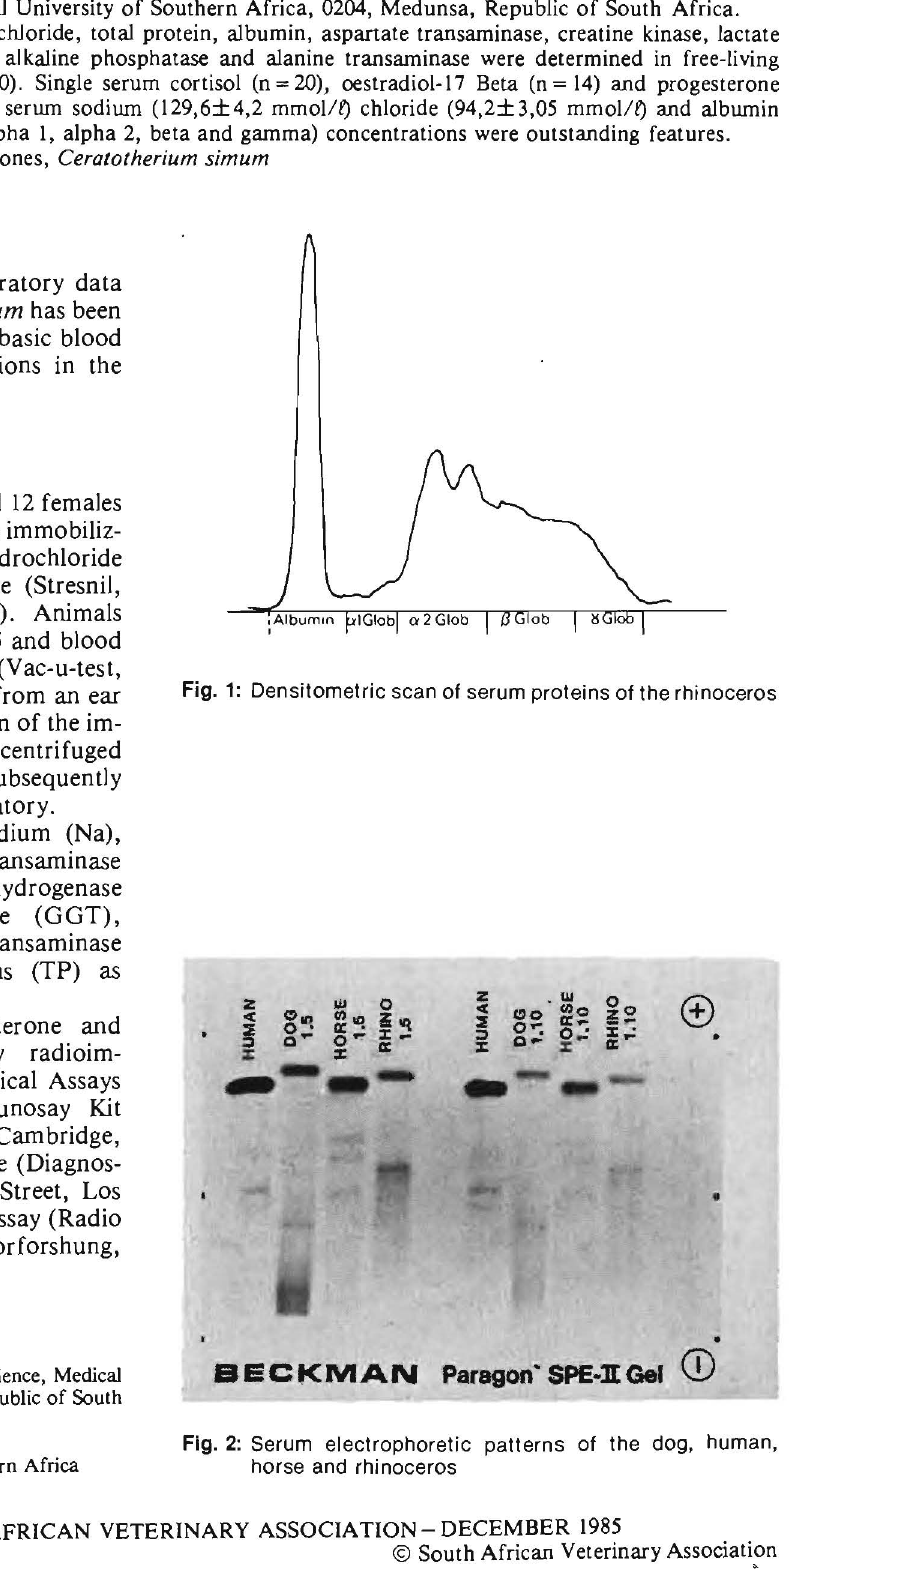
© South African Veterinary